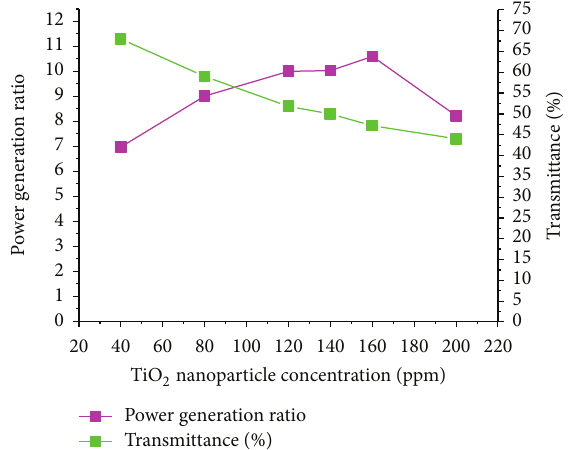
Figure 7: Simulation results of power generation ratio and trans- mittance for a 64 × 64 cm diffusive solar cell window with different concentrations of